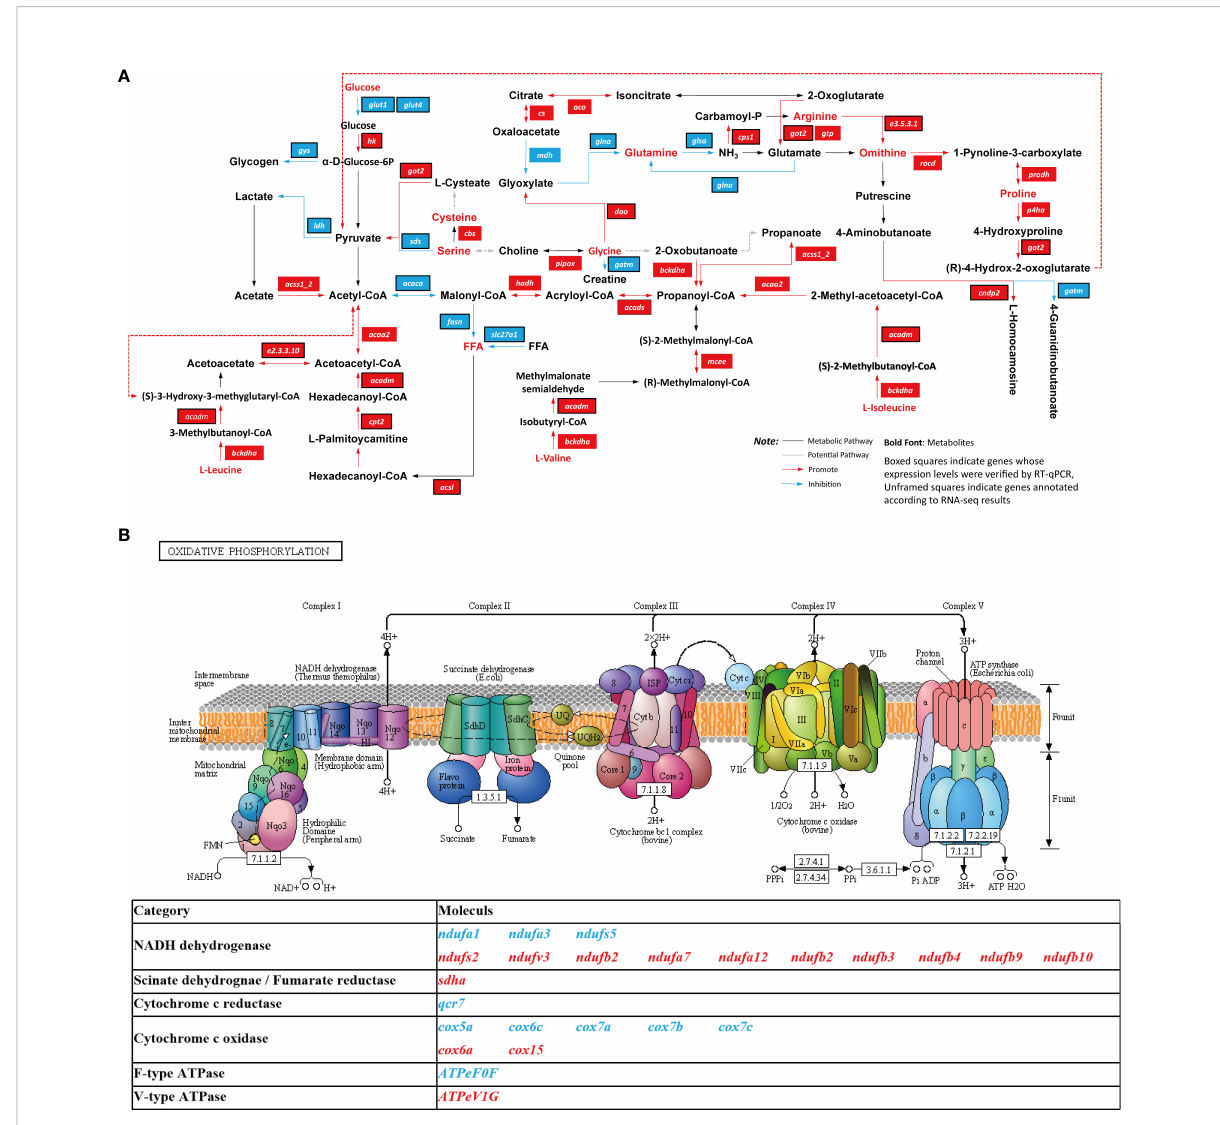
FIGURE 8 The simpli fi ed diagram of the nutrient metabolism and oxidative phosphorylation pathways in the muscle of the females at the LS. (A) The simpli fi ed diagram of the nutrient metabolism; (B) oxidative phosphorylation pathways in the muscle. The data were compared with the males at the LS; blue indicates down-regulation and red indicates